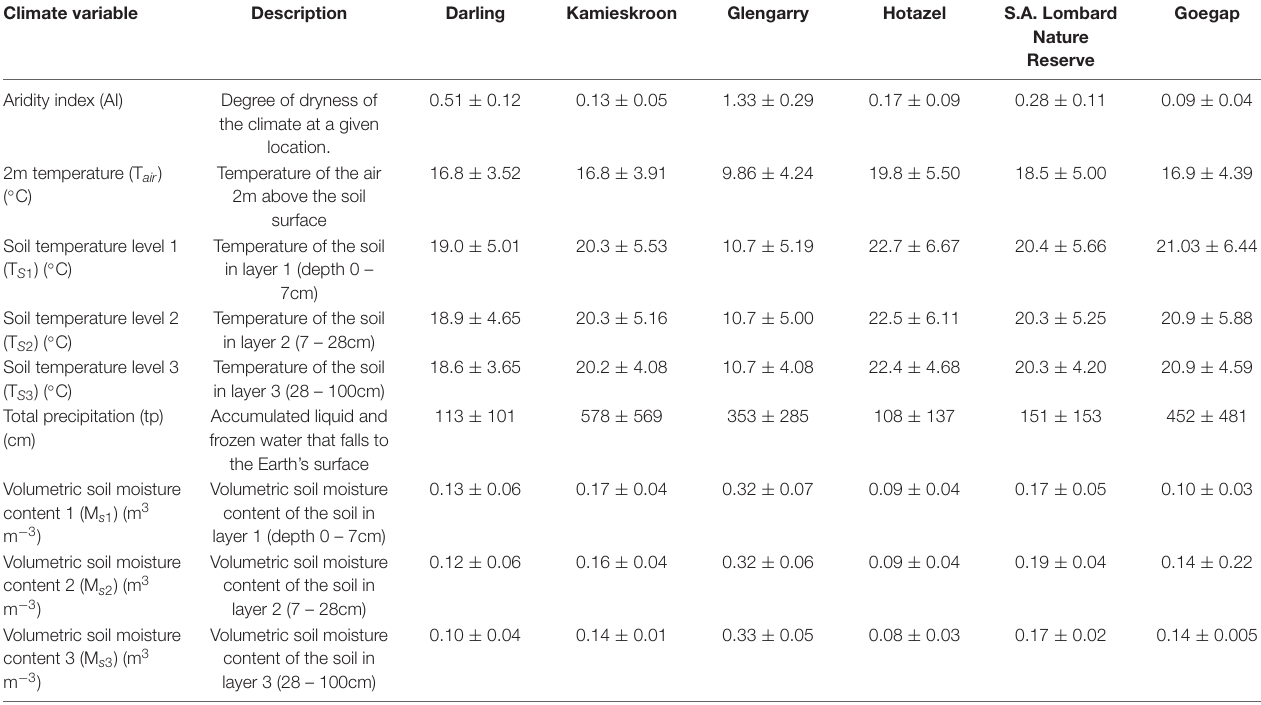
TABLE 3 | Variables from ERA5-Land dataset for each site from 1981 to 2020 used for analysis. Climate variable